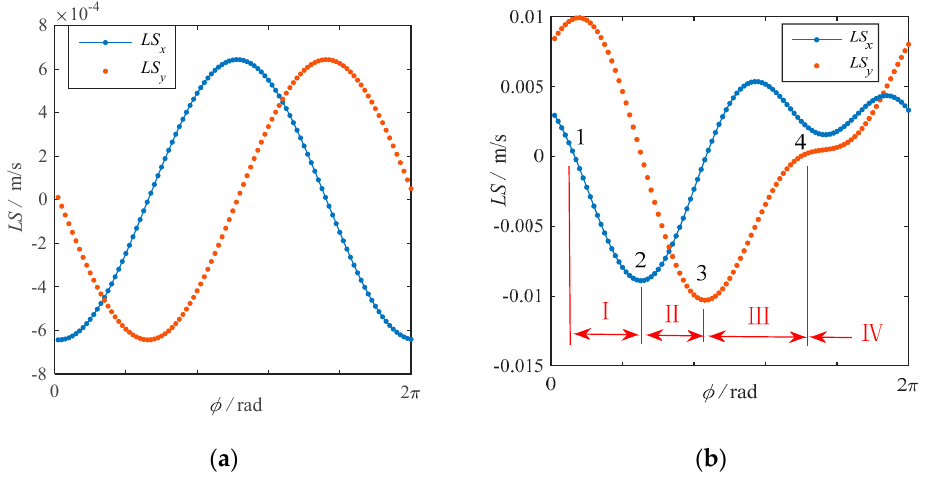
Figure 8. Line speed curves: ( a ) normal system, ( b ) cracked system.